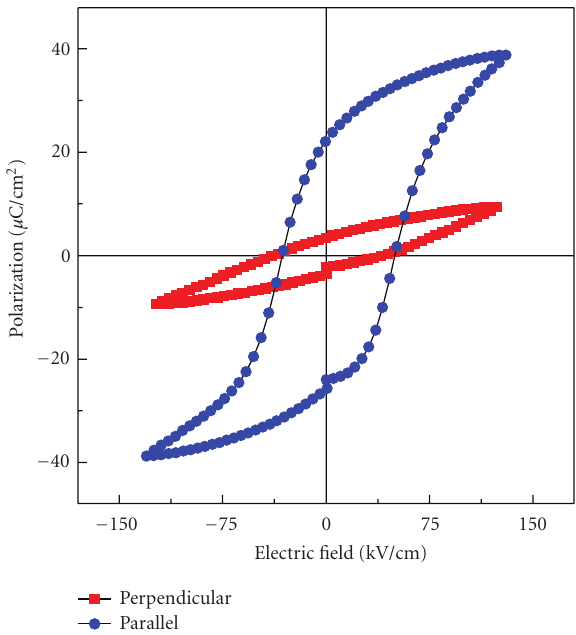
Figure 3: The ferroelectric-polarization hysteresis loops showing polarization versus electric field.